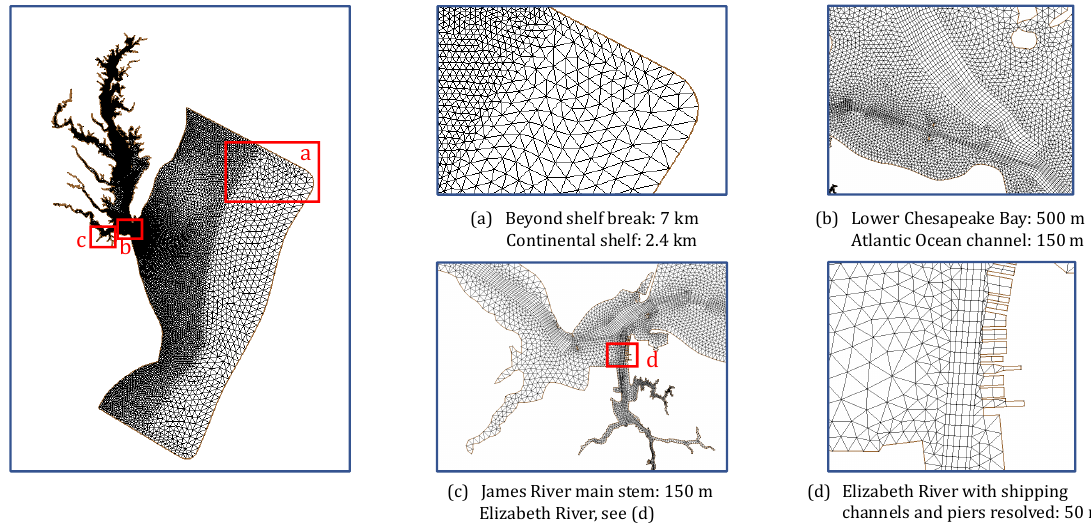
Figure 4. Illustration of the horizontal grid and the different resolutions in typical regions.